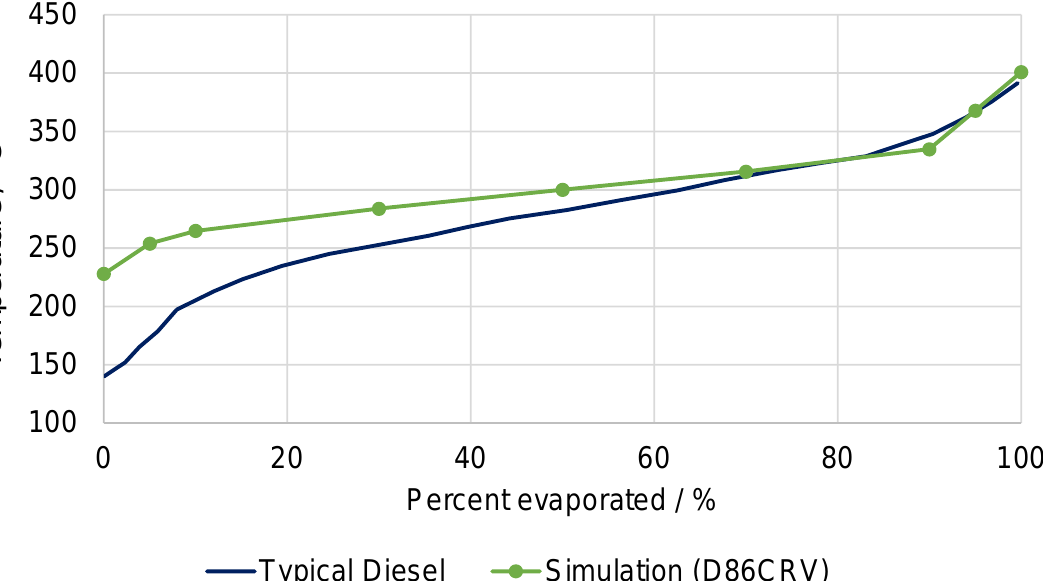
Figure 9. Boiling curves of jet fuel in comparison to Jet A-1 (boiling curve according to Edwards [61]).